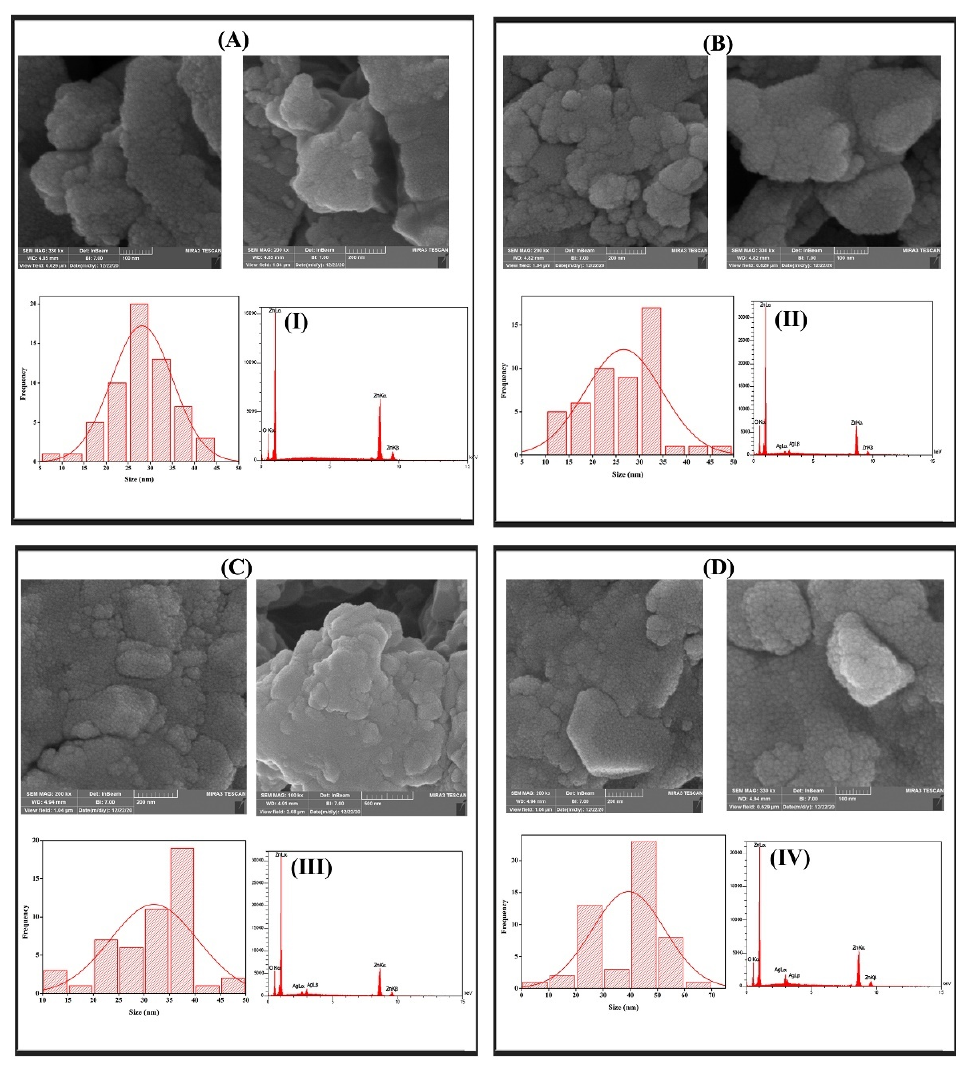
Figure 10. The FESEM images and EDS spectrum of the prepared Zn 1 − x Ag x O. ( A ) x = 0.0, ( B ) x = 0.03, ( C ) x = 0.06, and ( D ) x = 0.09.